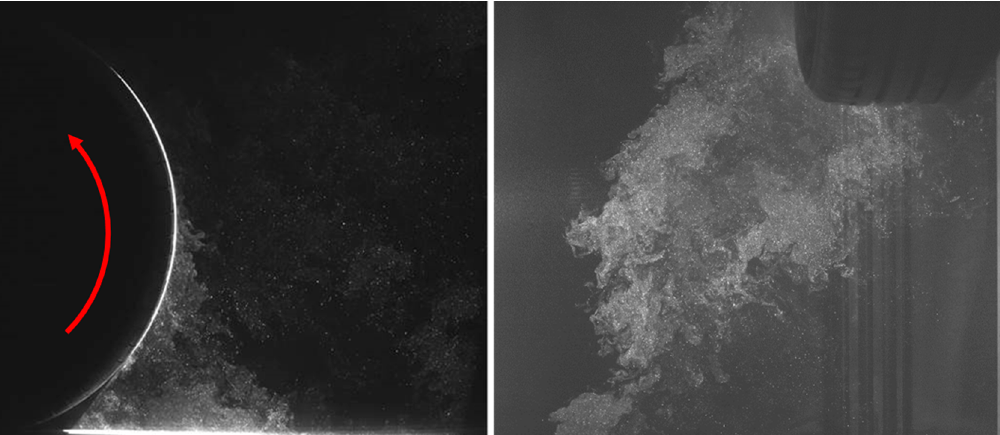
Figure 4. Distribution of injected model particles behind the tire road contact, represented by laser- illuminated planes ( left ) distribution via the center plane of the wheel; ( right ) distribution via a plane close to the road and representation of the P-shoulder swirl.